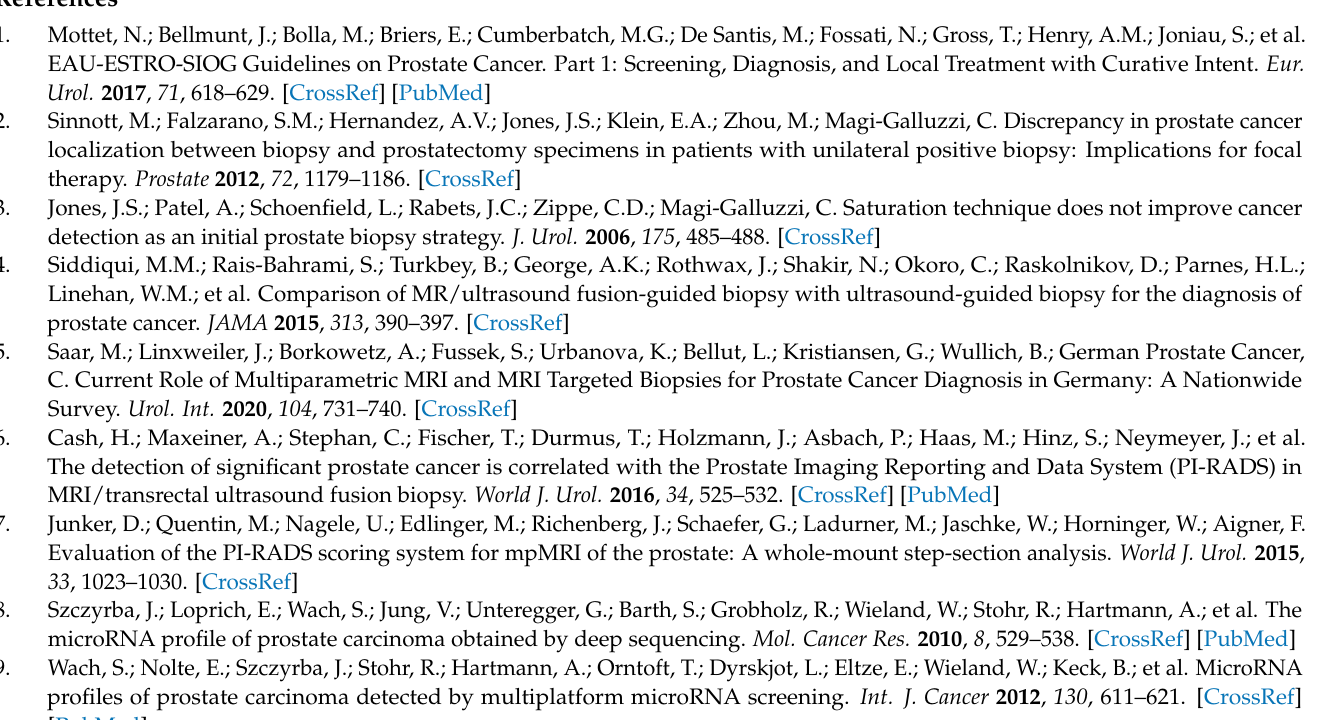
Table S1: Number of patients with corresponding Gleason scores and PI-RADS scores; Table S2: Comparison of pathological and predicted outcome; Covariates and regression coefficients of the optimized regression model for predicting tumor status; Table S3: Net expected regret differences at defined threshold cut-off values. Pair-wise comparisons of regret differences for the detection of significant PCa in patients with lesions of PI-RADS ≤